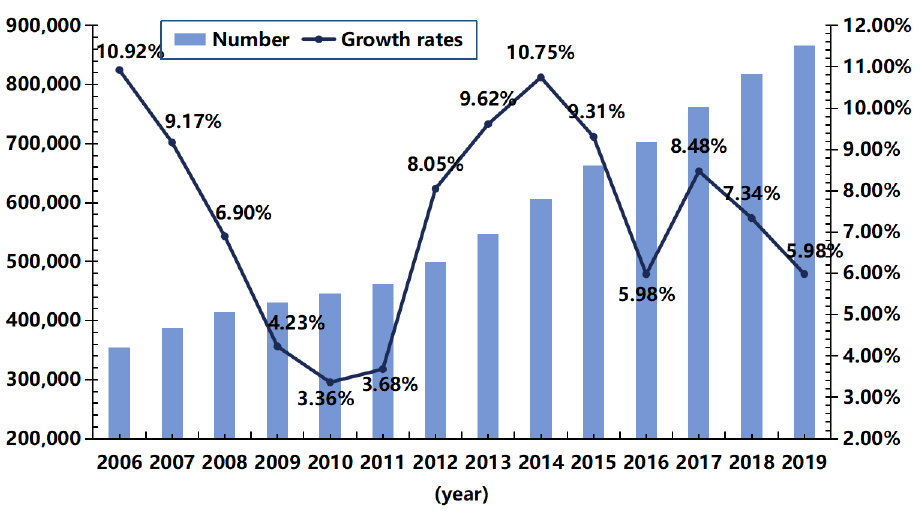
Figure 1. The development trend of social organizations in China before COVID-19 pandemic. Social organizations in China can be divided into three categories: “top-down”, “bottom-up”, and “external imported”. Government-run organizations and foundations are typical “top-down” social organizations. In contrast, the “bottom-up” social organization includes all kinds of local industry associations and private non-profit organizations. After China’s accession to the World Trade Organization(WTO), the “externally imported”